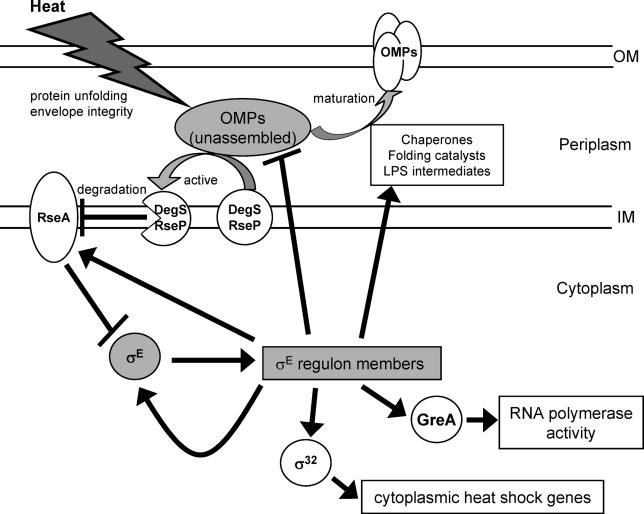
Functions of the Highly Conserved σE Core Regulon MembersStresses such as heat lead to the accumulation of unassembled OMPs; this activates the sequential proteolysis of the membrane-spanning antisigma RseA [12,54]. The inner membrane proteases DegS [b3235] and RseP [b0176] release the cytoplasmic portion of RseA, which is then degraded by the cytoplasmic proteases ClpX [b0438] and Lon [b0439] ([85]; R. Chaba unpublished data) to release free σE, which then binds to RNA polymerase core to regulate the expression of target regulon members. σE up-regulates functions required for synthesis, assembly, and/or insertion of both OMPs and LPS, the most abundant components of the outer membrane, as well as envelope-folding catalysts and chaperones. σE also up-regulates expression of itself and its negative regulator RseA and enhances expression of GreA [b3181] and σ32 [b3461]. Importantly, σE down-regulates OMP expression, thereby reducing the accumulation of unassembled OMPs, which presumably limits the duration of the response.